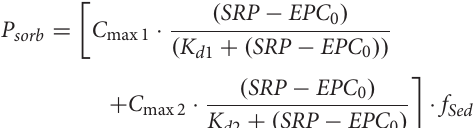
conditions), the adsorbed SRP was the basis for the estimation